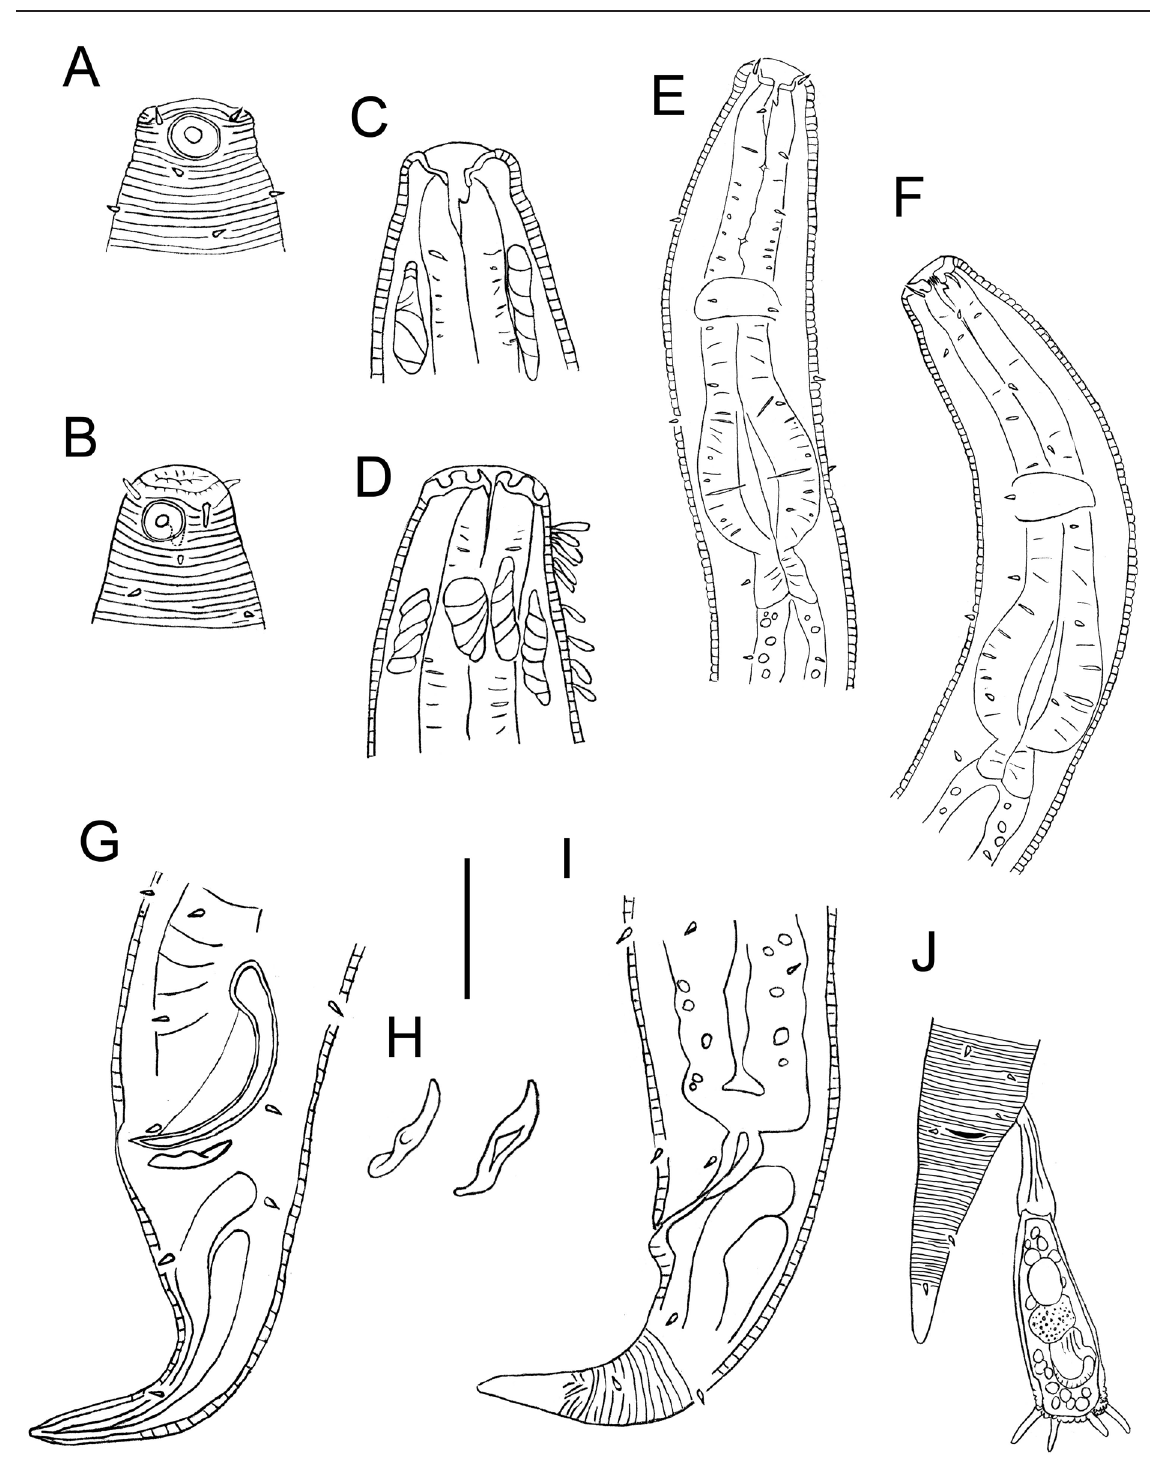
Fig. 1. Spirinia verecunda sp. nov. A . Surface view of male head. B–C . Male head, showing buccal cavity. D . Female head, showing bacteria attached to cuticle. E . Anterior body region of male. F . Anterior body region of female. G . Posterior body region of male. H . Gubernaculum, with details of crurae (left) and cuneus (right). I . Posterior body region of female. J . Posterior body region of female, showing attached protist. Scale bar: A–D, I = 20 µ m, E–F = 30 µ m, G = 16 µ m, H = 12 µ m, J = 35 µ